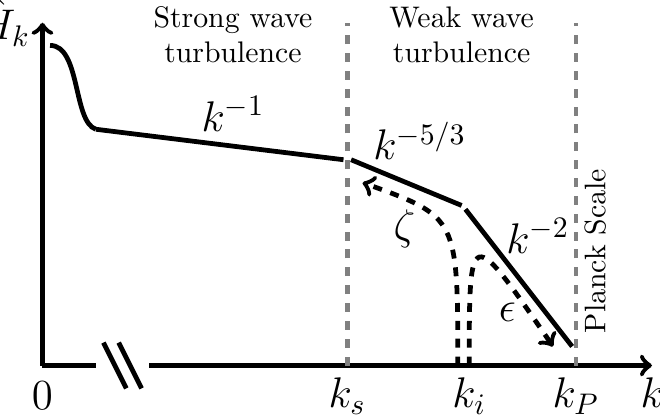
Figure 1. 1D metric spectrum ˆ H k produced by an injection of wave action and energy fluxes at wavenumber k i . The weak GW turbulence regime is localized in the interval k s < k is the Planck wavenumber and k s determines the wavenumber below which GW turbulence is strong. In this scenario, the inverse cascade leads to the formation of a condensate at k = 0. The growth of the condensate corresponds to an increase of the cosmic scale